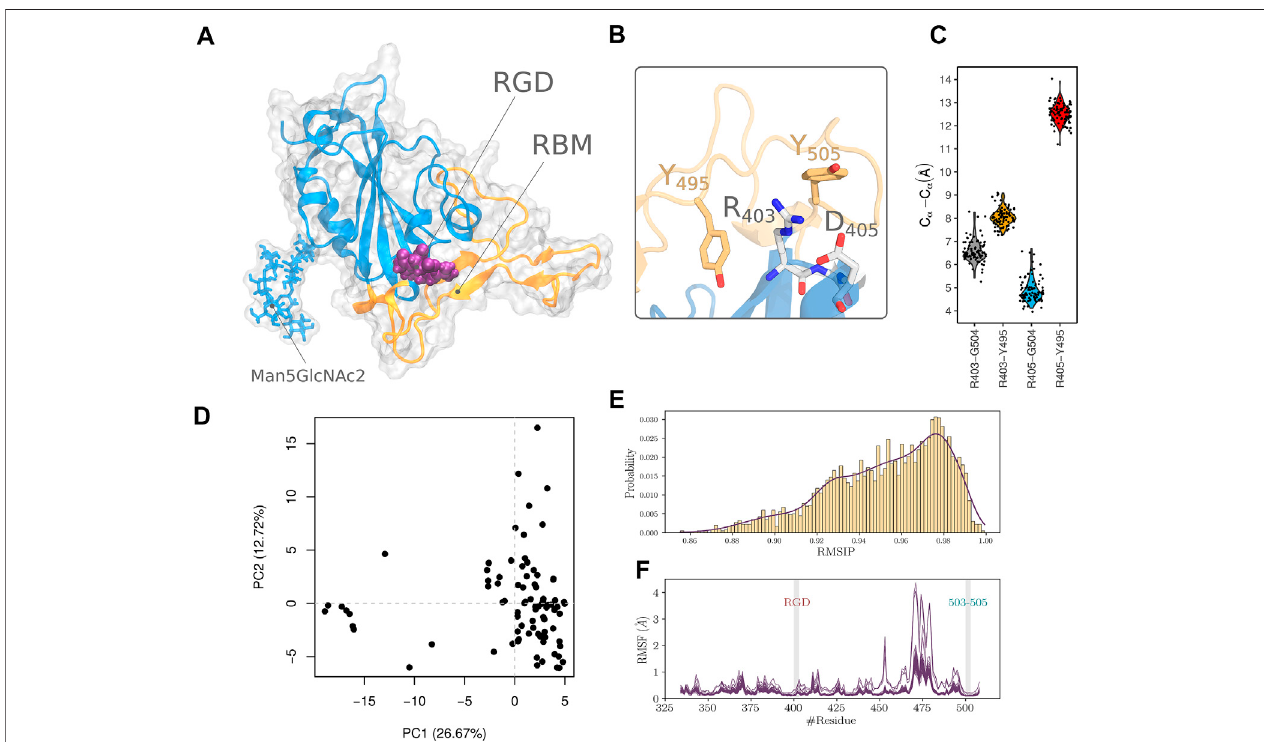
FIGURE 1 | Analysis of the RBD structural ensemble. (A) Structure of RBD showing the RGD motif, the Man5GlcNAc2 polysaccharide and the RBM segment. (B) Arrangement oftheRGDmotif relativetoresidue Y505and Y495. (C) Statistical measurementsofdistancesbetween RGD residues and D405and Y495collectedfrom the ensemble of experimental structures. (D) Projection of RBD structure in the PC1-PC2 subspace of the PCA performed on pre-aligned and superimposed ensemble of structures. (E) RMSIP density plot calculated using the normal modes of each pair of structures of the ensemble. (F) RMSF pro fi le of all the structures in the ensemble computed from all atoms normal mode